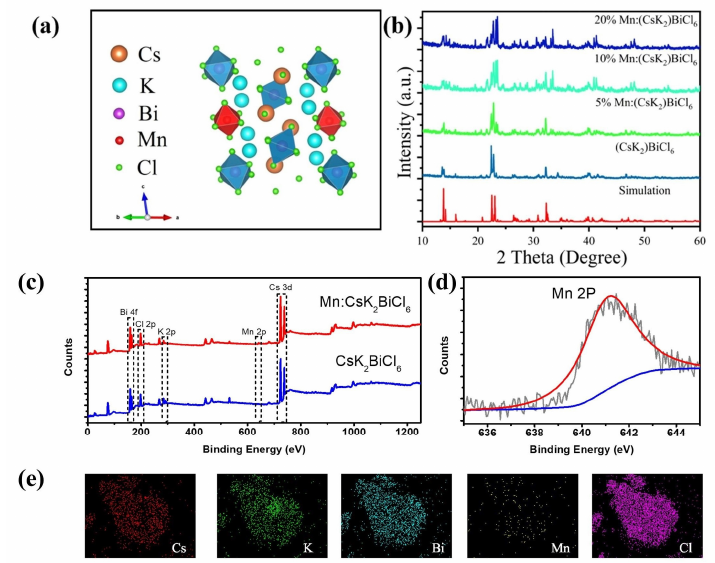
Figure 4. ( a ) The crystal structure diagram of (CsK 2 )BiCl 6 . ( b ) Power XRD patterns for Mn-doped (CsK 2 )BiCl 6 with different Bi/Mn feed ratios. ( c ) The XPS spectra of (CsK 2 )BiCl 6 and Mn: (CsK 2 )BiCl 6 (Mn/Bi = 0.1). ( d ) High-resolution XPS spectra and peak fitting for Mn 2p of Mn-doped (CsK 2 )BiCl 6 (Mn/Bi = 0.1). ( e ) EDS mapping of the Cs, K, Bi, Cl and Mn elements of Mn: (CsK 2 )BiCl 6 (Mn/Bi = 0.1).